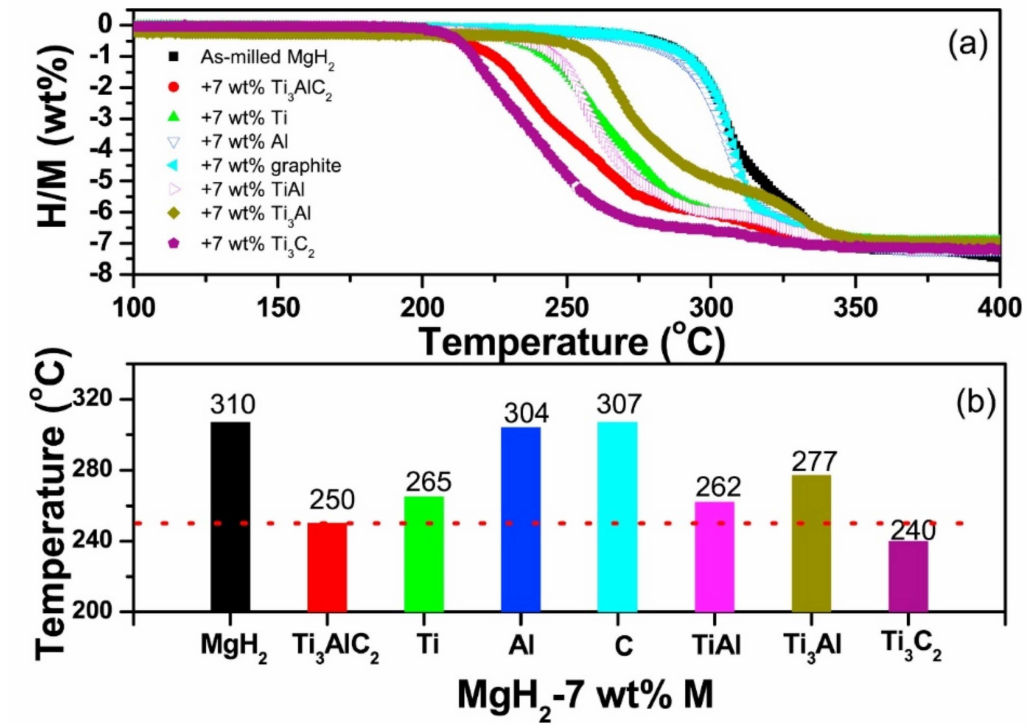
Figure 18. ( a ) Volumetric release and ( b ) midpoint dehydrogenation temperature of MgH 2 -7 wt% M (M = Ti 3 AlC 2 , Ti, Al, graphite, Ti 3 C 2 , TiAl and Ti 3 Al) composites [135]. (Reprinted with permission from